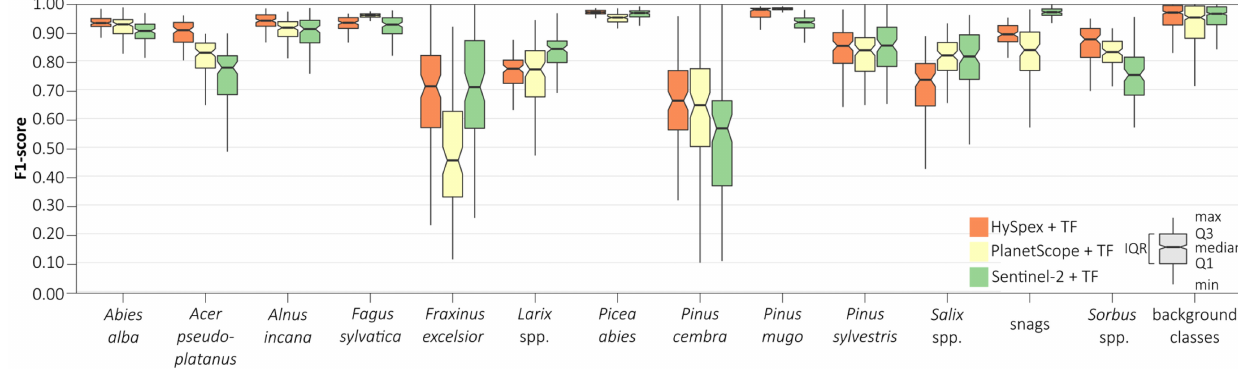
Figure 9. F1-score values for classes based on 100 iterations for 700 pixels with support vector machine as the classifier. IQR, interquartile range; Q1, lower quartile; Q3, upper quartile; TF, topographic features; (digital elevation model, canopy height model, and slope and aspect